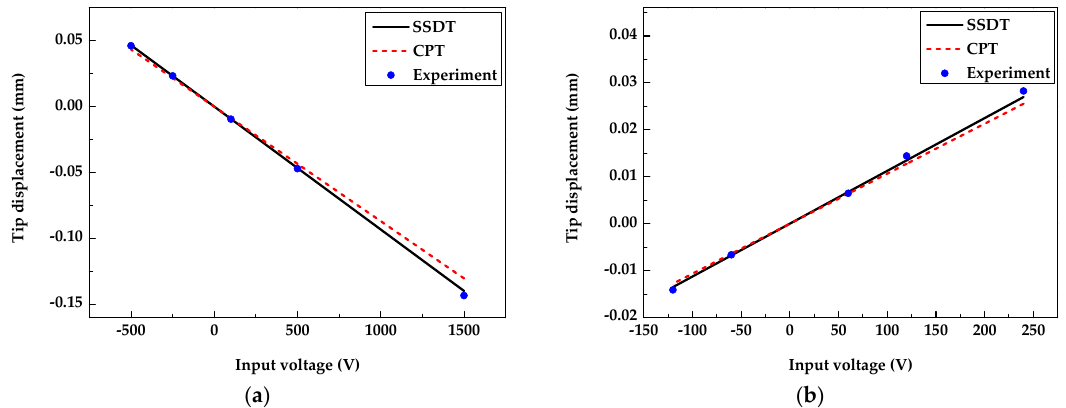
Figure 9. End displacement comparison of MFC laminated beams. ( a ) The P1 type of MFC; ( b ) the P2 type of MFC.